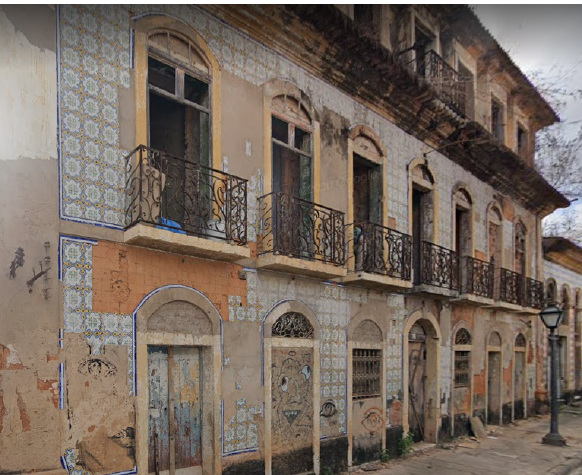
Figure 9. Case study building fac¸ade.